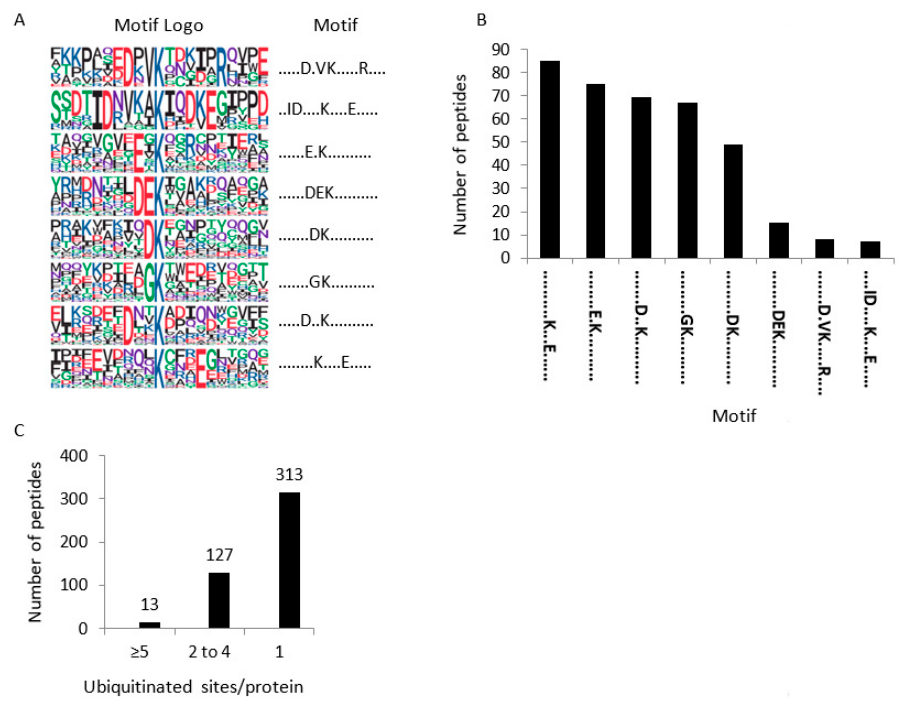
Figure 3. Motif analysis of identified K-Ub residues in root microsomes. ( A ) Ubiquitination motifs and the conservation of K-Ub residues. The height of each letter corresponds to the frequency of the amino acid residue in that position. The central K refers to the K-Ub residue. ( B ) The number of identified peptides containing a K-Ub residue in each motif. ( C ) The number of K-Ub sites per protein.